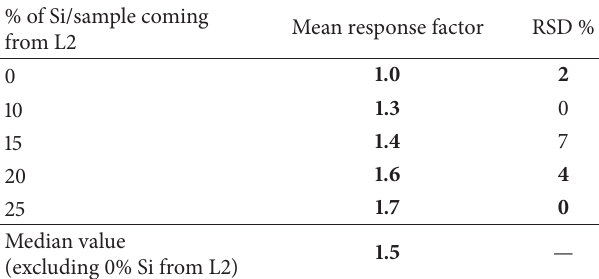
Table 2: Determination of the mean response factors observed by ICP-OES at − 10 ∘ C for the 3 standards solutions at 2, 4, and 5 mgSi/L (L5